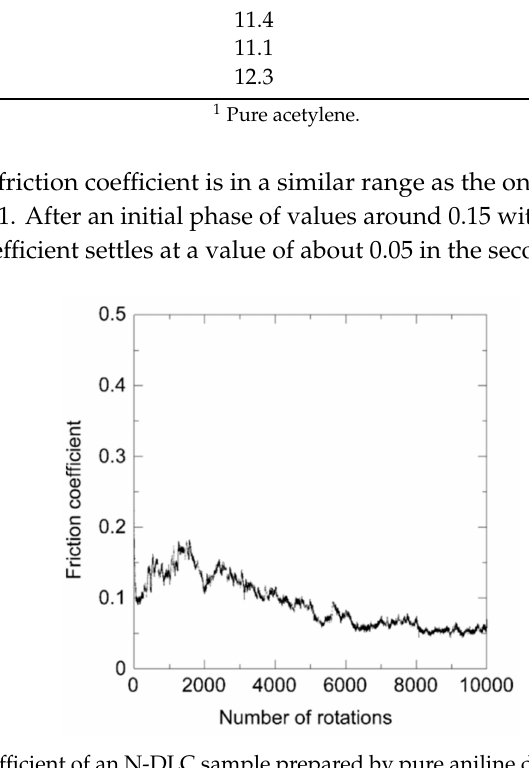
Figure 9. Friction coe ffi cient of an N-DLC sample prepared by pure aniline during the ball-on-disk test.